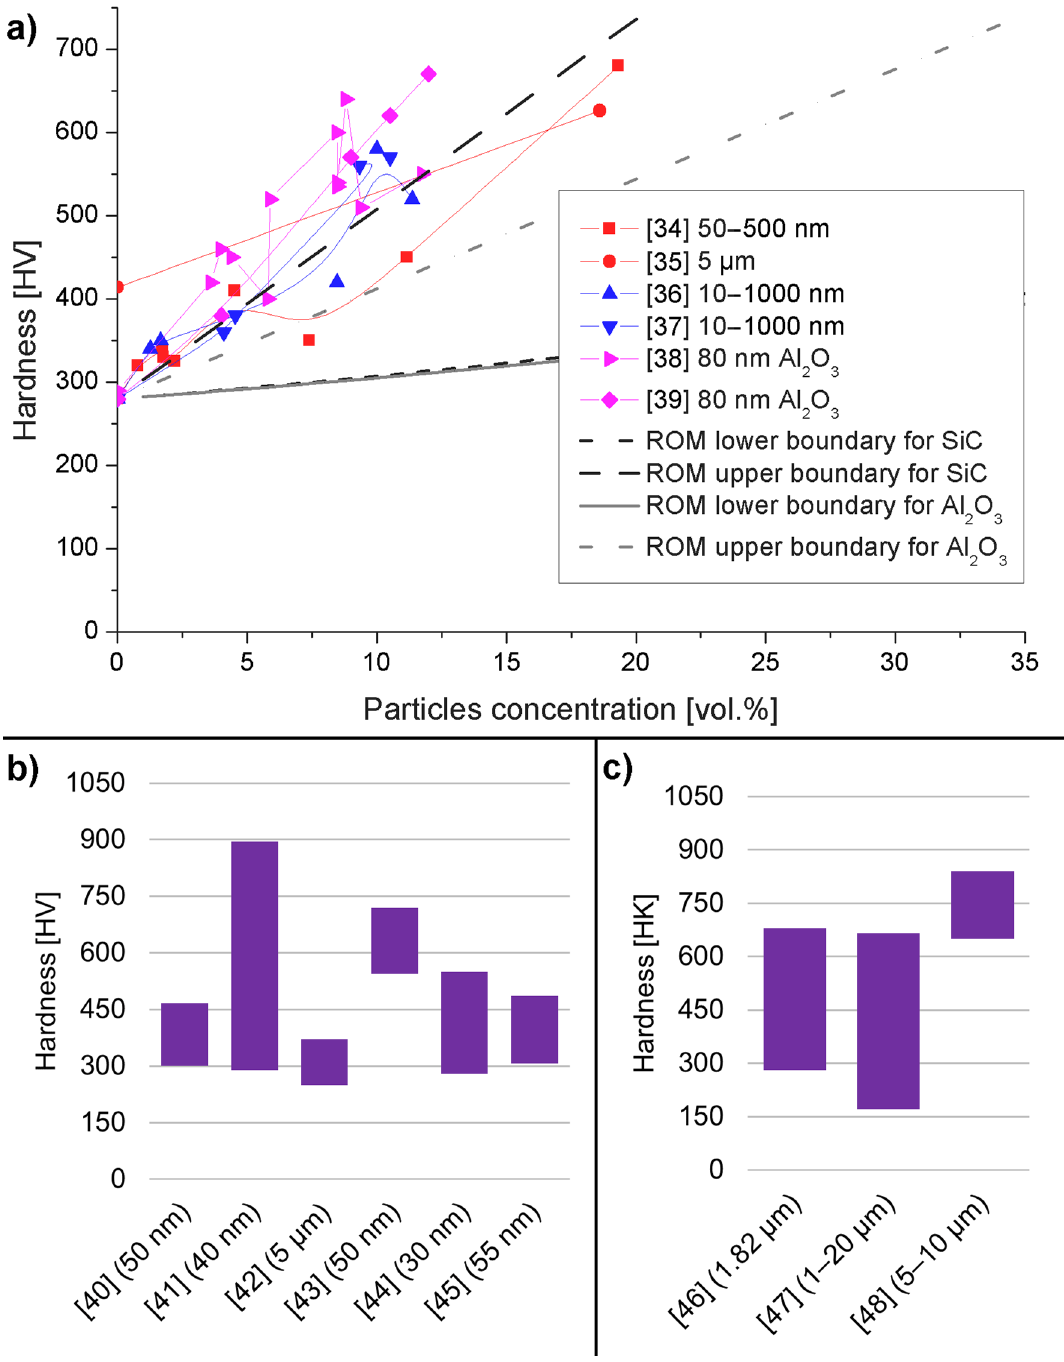
Figure 1. Results from the literature for pure nickel matrix with SiC reinforcement: ( a ) micro Vickers indentation with a specified volume fraction of reinforcement particles, ( b ) Vickers indentations without a specified volume fraction of reinforcement, and ( c ) Knoop indentation.